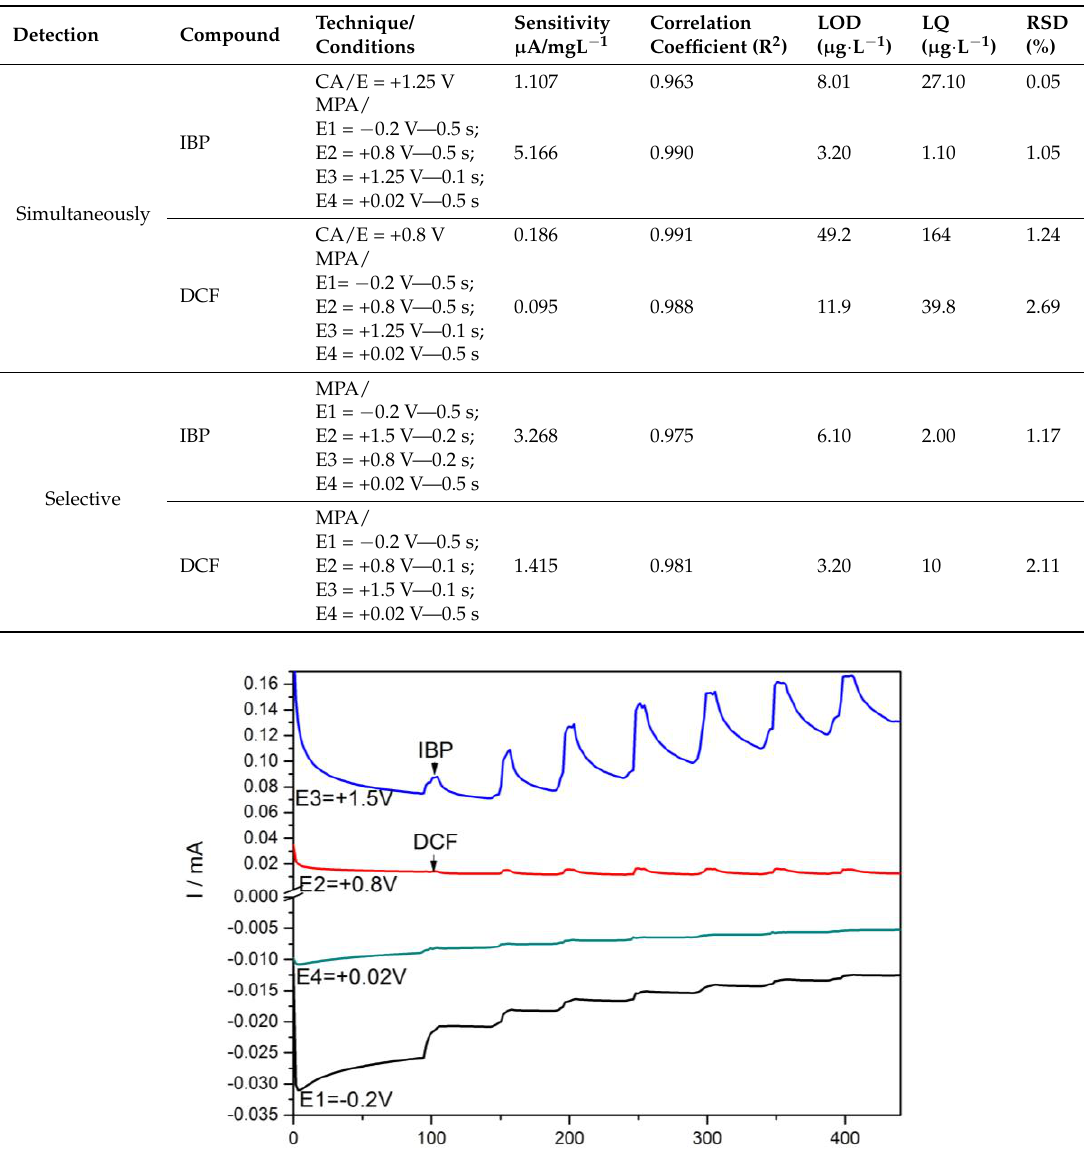
Table 2. The electroanalytical parameters reached for the selective/simultaneous detection of IBP and DCF with a HKUST-CNF electrode.